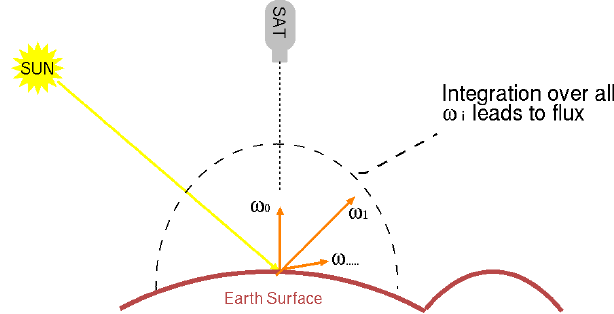
Figure 3. Flux is defined as the integration of all radiances over the sphere. The satellite observes the radiance for a specific direc- tion. The reflection of the Earth atmosphere is usually not isotropic (equal amount of radiation in all directions) but depends on the spe- cific direction and viewing